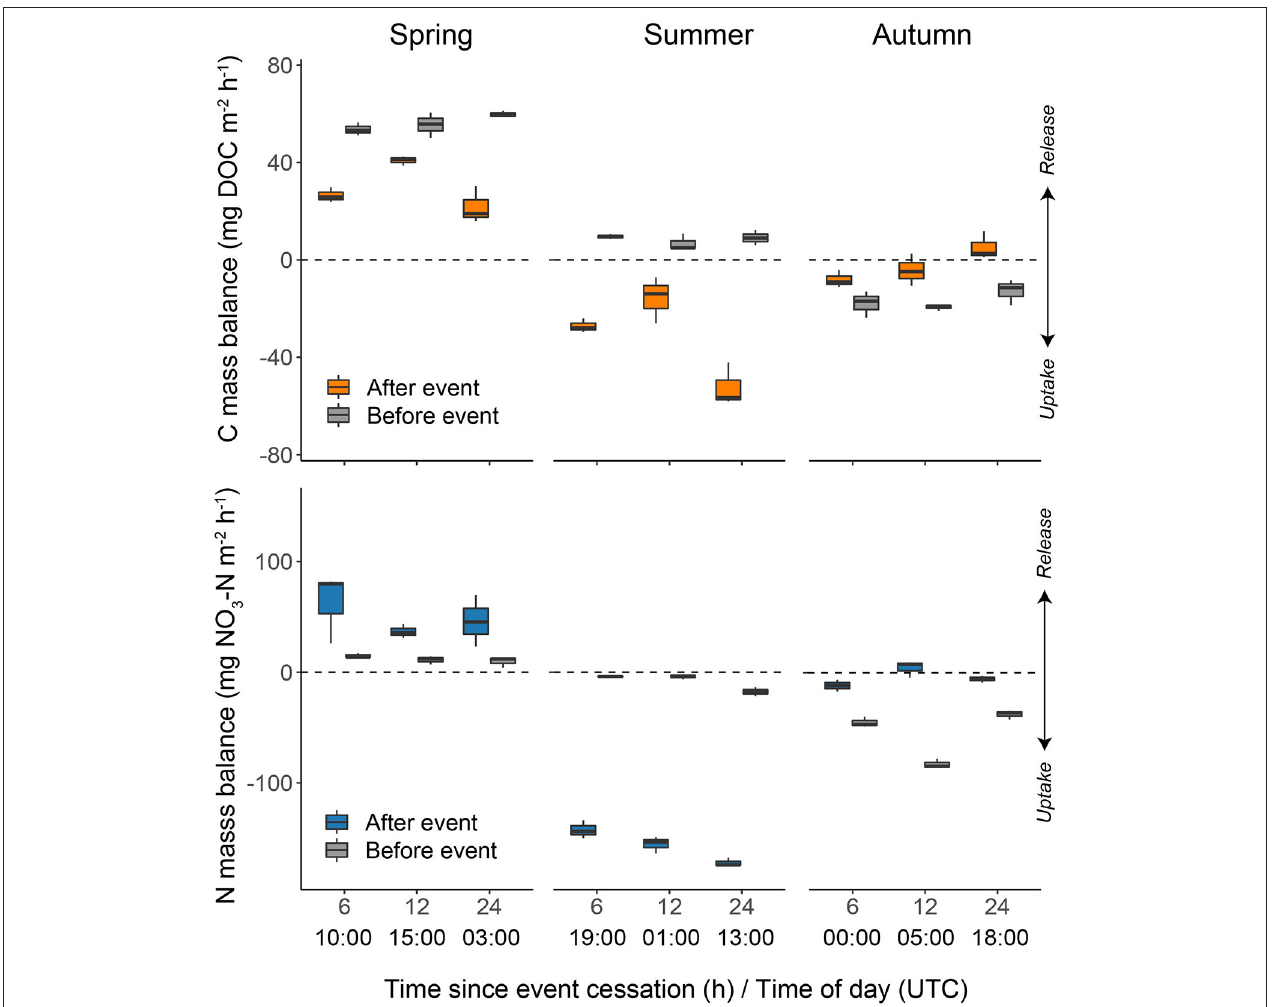
FIGURE 10 | Boxplots of NO − 3 -N and DOC mass balance at 6, 12, and 24h post selected storm events in spring, summer, and autumn. Post-event uptake rates are normalised to pre-event rates. Pre-event rates at the same time of day are shown for comparison. Note for each time point the mean of ± 1h is calculated; for example the 1300h value is the mean of 1200h, 1300h, and 1400h. The bold line of the boxplot indicates the median with the lower and upper hinges representing the first and third quartiles of the data, respectively. The smallest (largest) value is indicated by the lower (upper) whisker, however, the whiskers do not extend past 1.5 times the inter-quartile